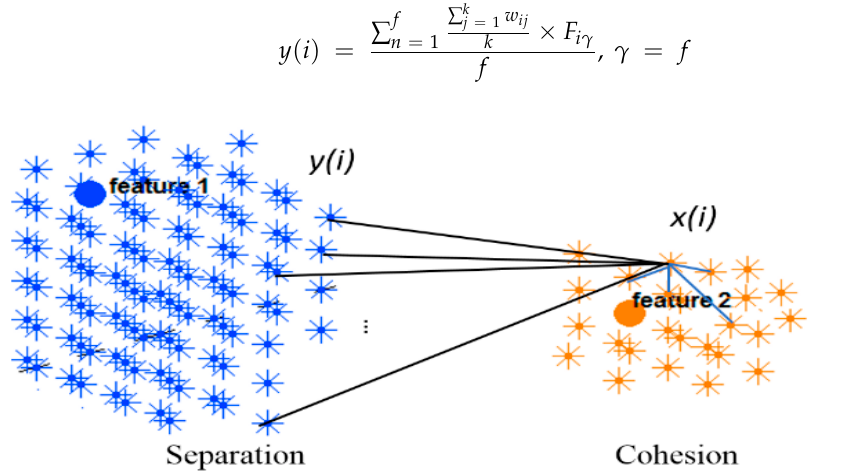
Figure 5. Silhouette method exemplified on two